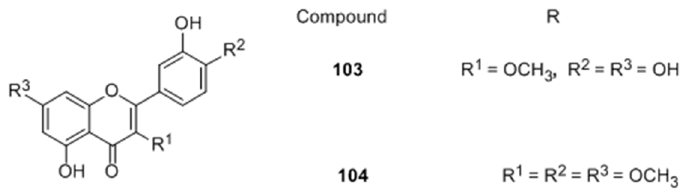
Figure 14. Structures of the synthesized quercetin derivatives.